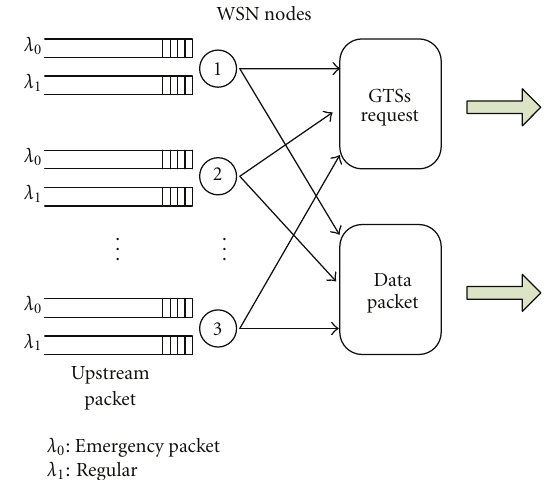
Figure 8: Queuing model from WSN end nodes to WSN coordina- tor.